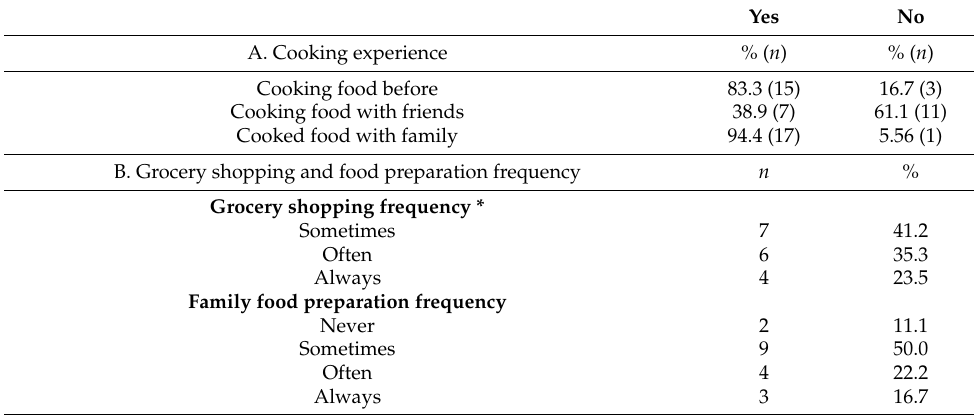
Table 1. Cooking experience and frequency of grocery shopping and food